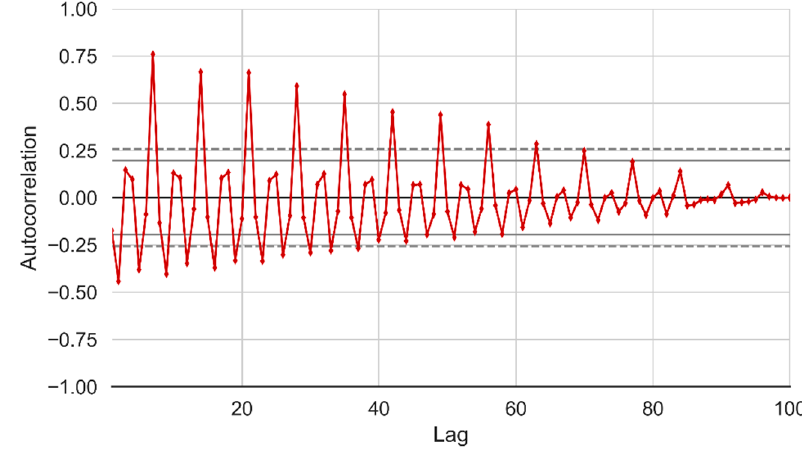
Figure 14. Autocorrelation function (ACF) plot.